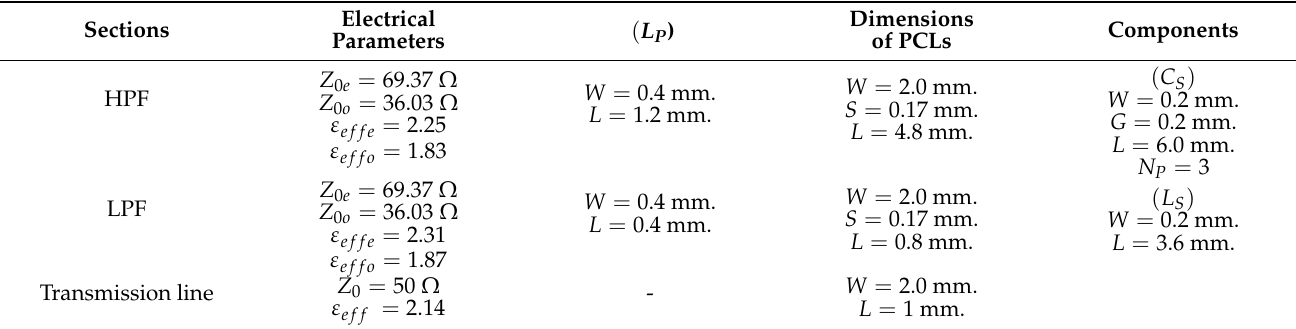
Table 2. Parameters for computer simulations with AD260A